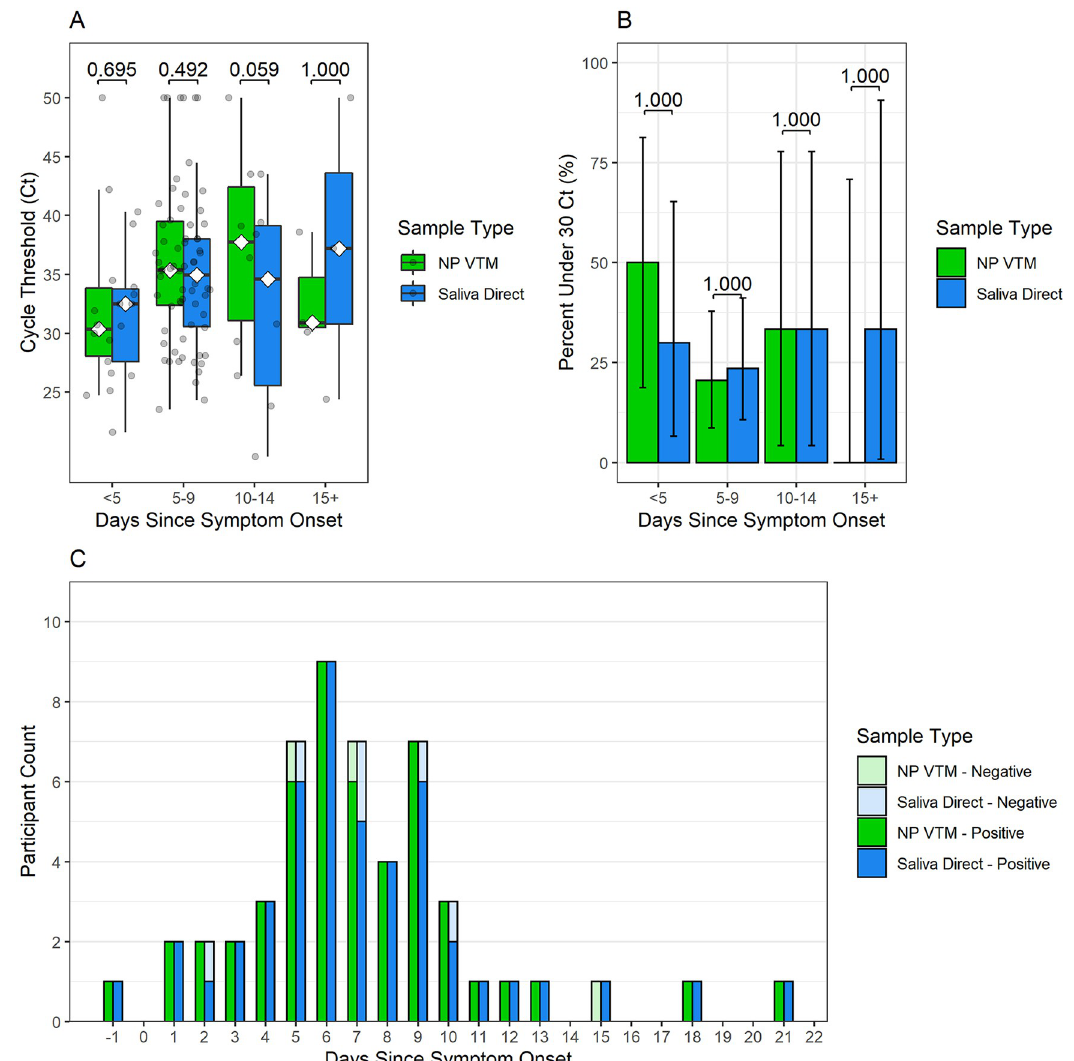
Fig 3. SARS-CoV-2 longevity in overall analysis cohort saliva and nasopharyngeal (NP) specimens. (A) Ct values, (B) percent of Ct values under 30 and (C) number of positive and negative test results for saliva direct and NP VTM specimens by days since symptom onset for all participants in the overall cohort with both saliva and NP at baseline (n =